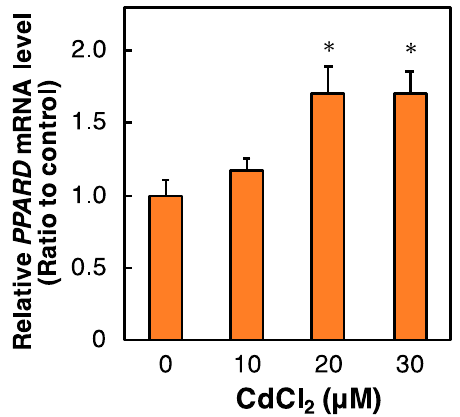
Figure 3. Effect of Cd on the PPARD mRNA level in HK-2 cells. HK-2 cells were treated with Cd for 6 h. PPARD mRNA levels were examined by real-time RT-PCR after Cd treatment for 6 h. PPARD mRNA levels were normalized to GAPDH mRNA levels. Values are means ± SD ( n = 3). * Significantly different from the control group, p < 0.05.